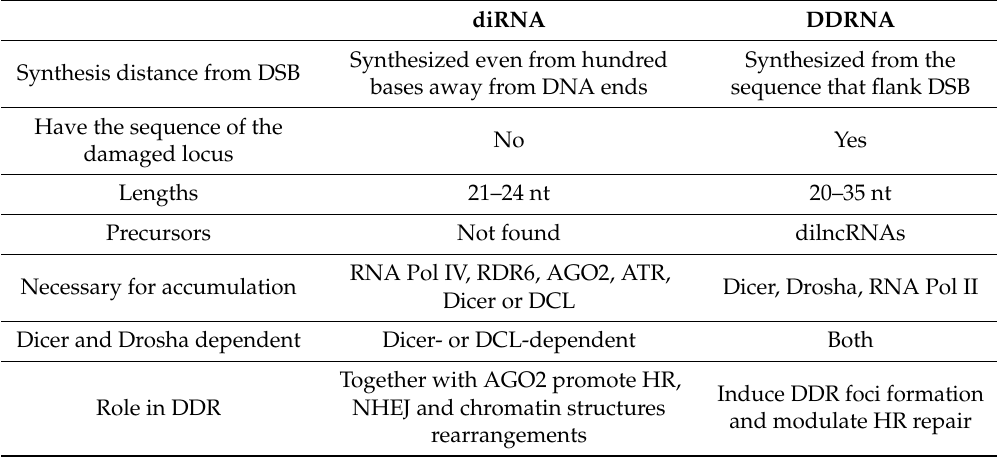
Table 1. Di ff erences between diRNA and